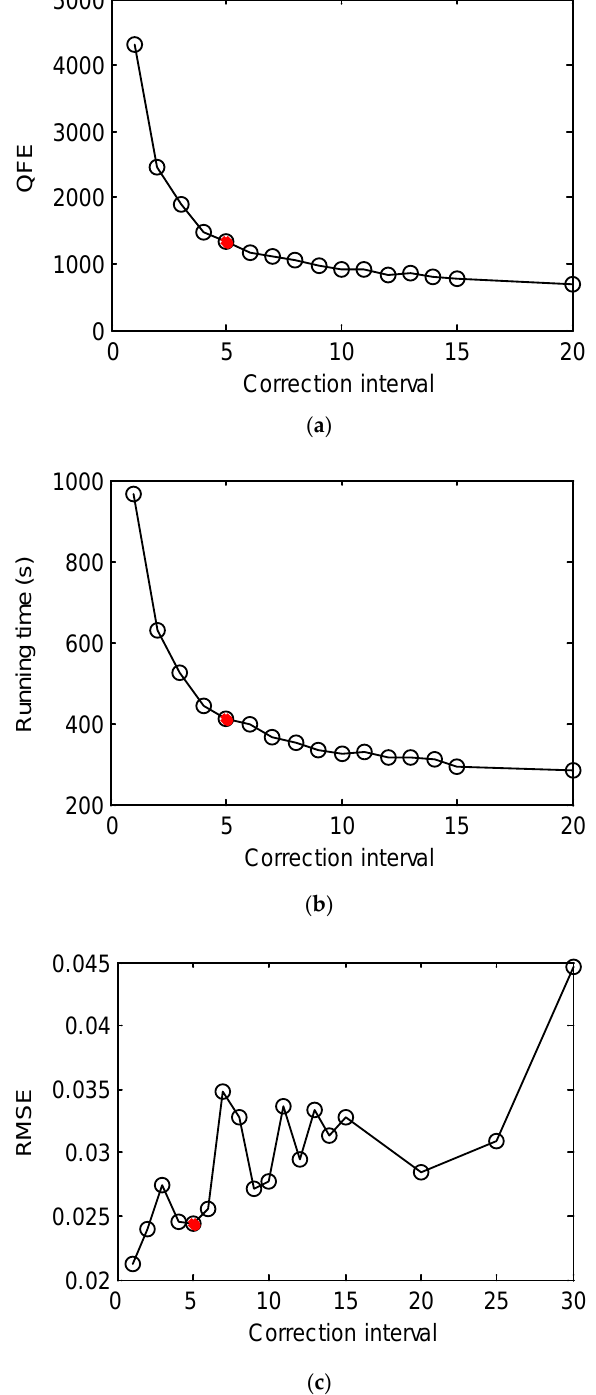
Figure 17. Fault diagnosis with different correction intervals of PLS under fault 8 with respect to ( a ) QFE; ( b ) the running time; ( c ) RMSE.